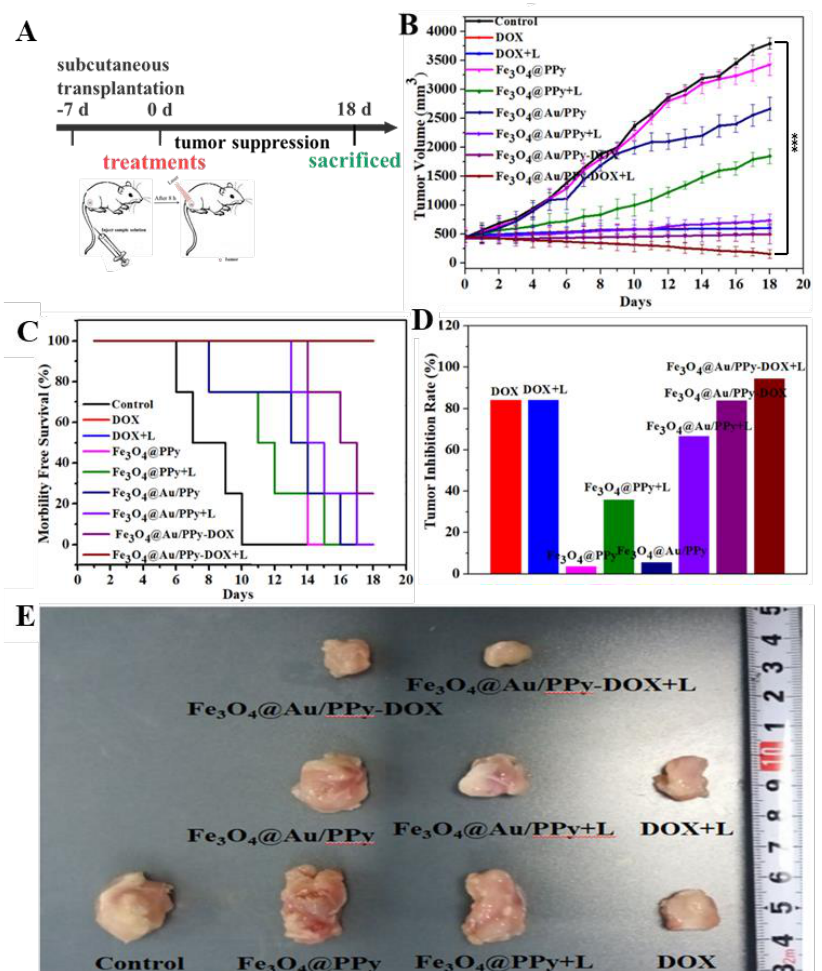
Figure 7. In vivo synergistic antitumor effect of products. ( A ) Schematic diagram of the samples in vivo anticancer therapy. ( B ) Tumor volume curves, ( C ) survival curves, ( D ) tumor inhibition rate and ( E ) representative tumor photos of H22 tumor-bearing mice after different treatments. Means ± SD (n = 5). *** p < 0.001.